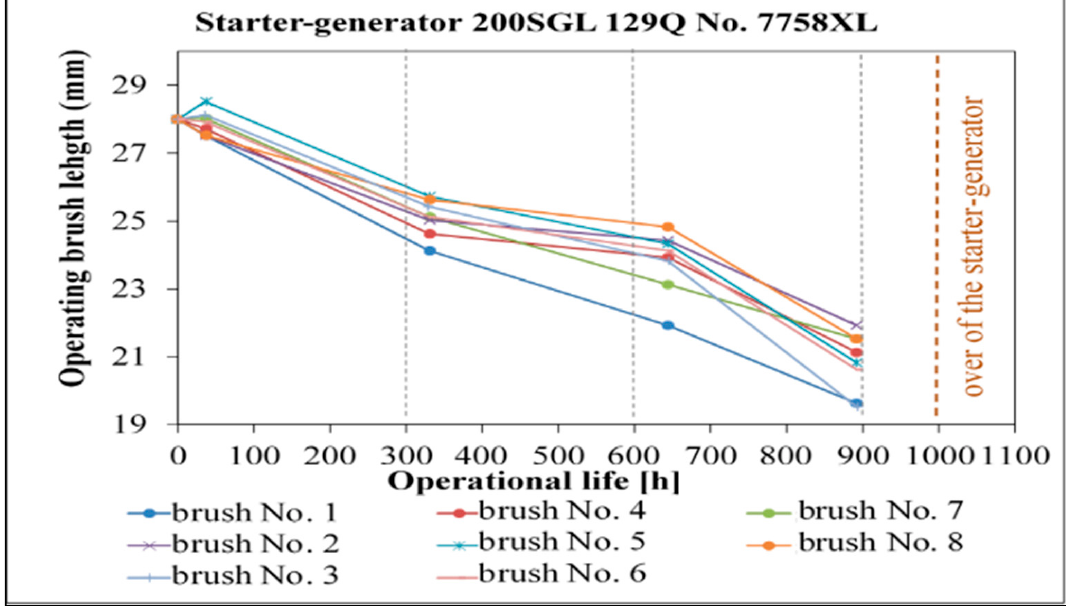
Figure 4. The diagram of wear of 200SGL129Q starter-generator No. 7758XL in function of the operating time.